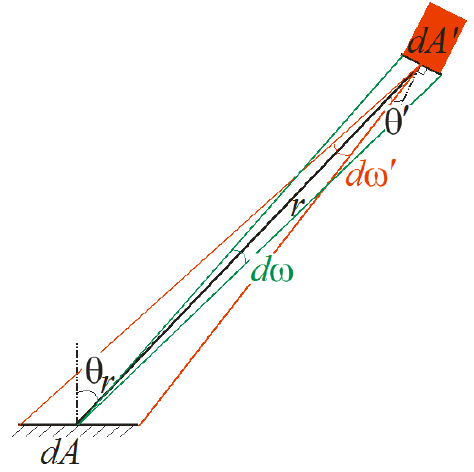
Figure A1. Schematic diagram of a light beam from the ground small area (cid:1856)(cid:1827) to the